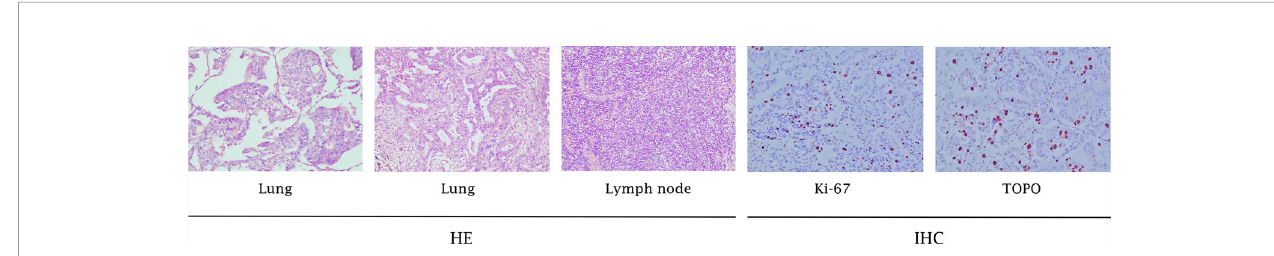
FIGURE 1 | Pathology results. H&E staining of the biopsy specimen showed poorly-differentiated NSCLC. IHC staining showed positive expression of Ki-67 and TopoII